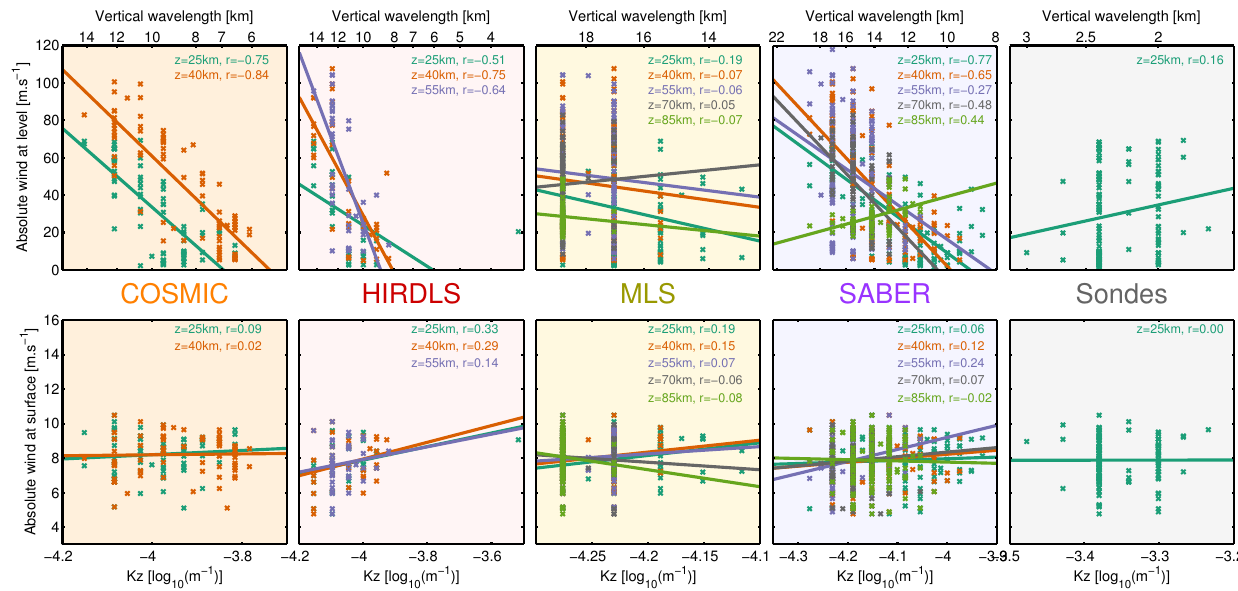
Figure 18. Scatter plots of observed vertical wavenumber against absolute wind speed for each height level (top row) Same data against surface absolute wind speed (bottom row). [ r ] indicates the Pearson correlation coefficient at each level. Horizontal axes apply to both upper and lower panels.